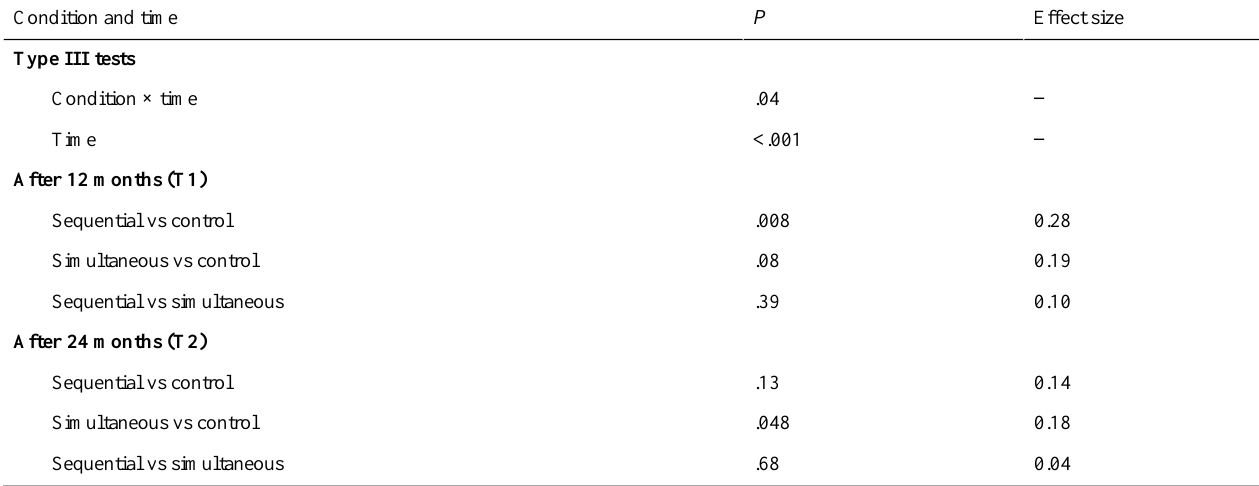
Table 2. Results of linear mixed model analyses (top-down procedure) a with the risk factor score after 12 and 24 months as outcome measure.